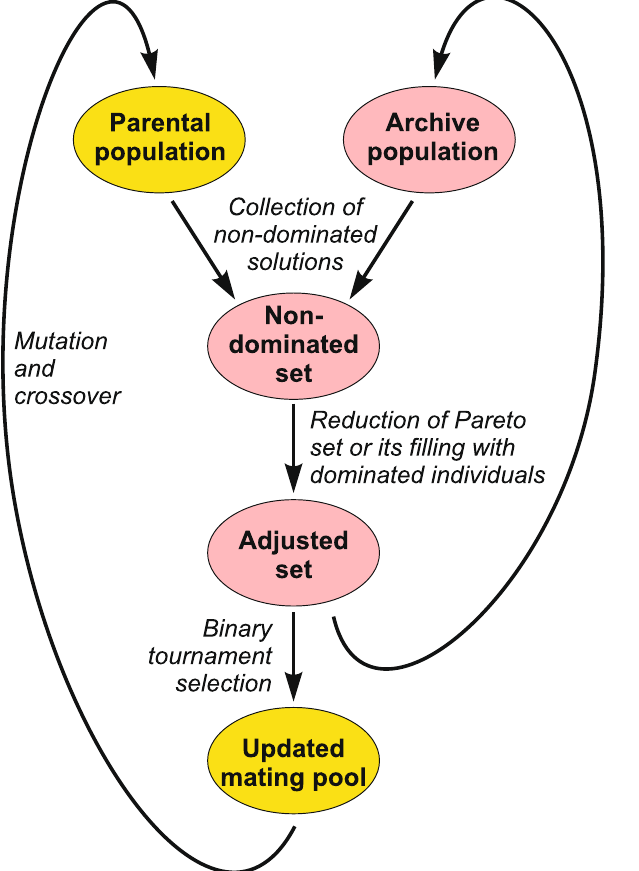
Figure 8. The workflow of the algorithm